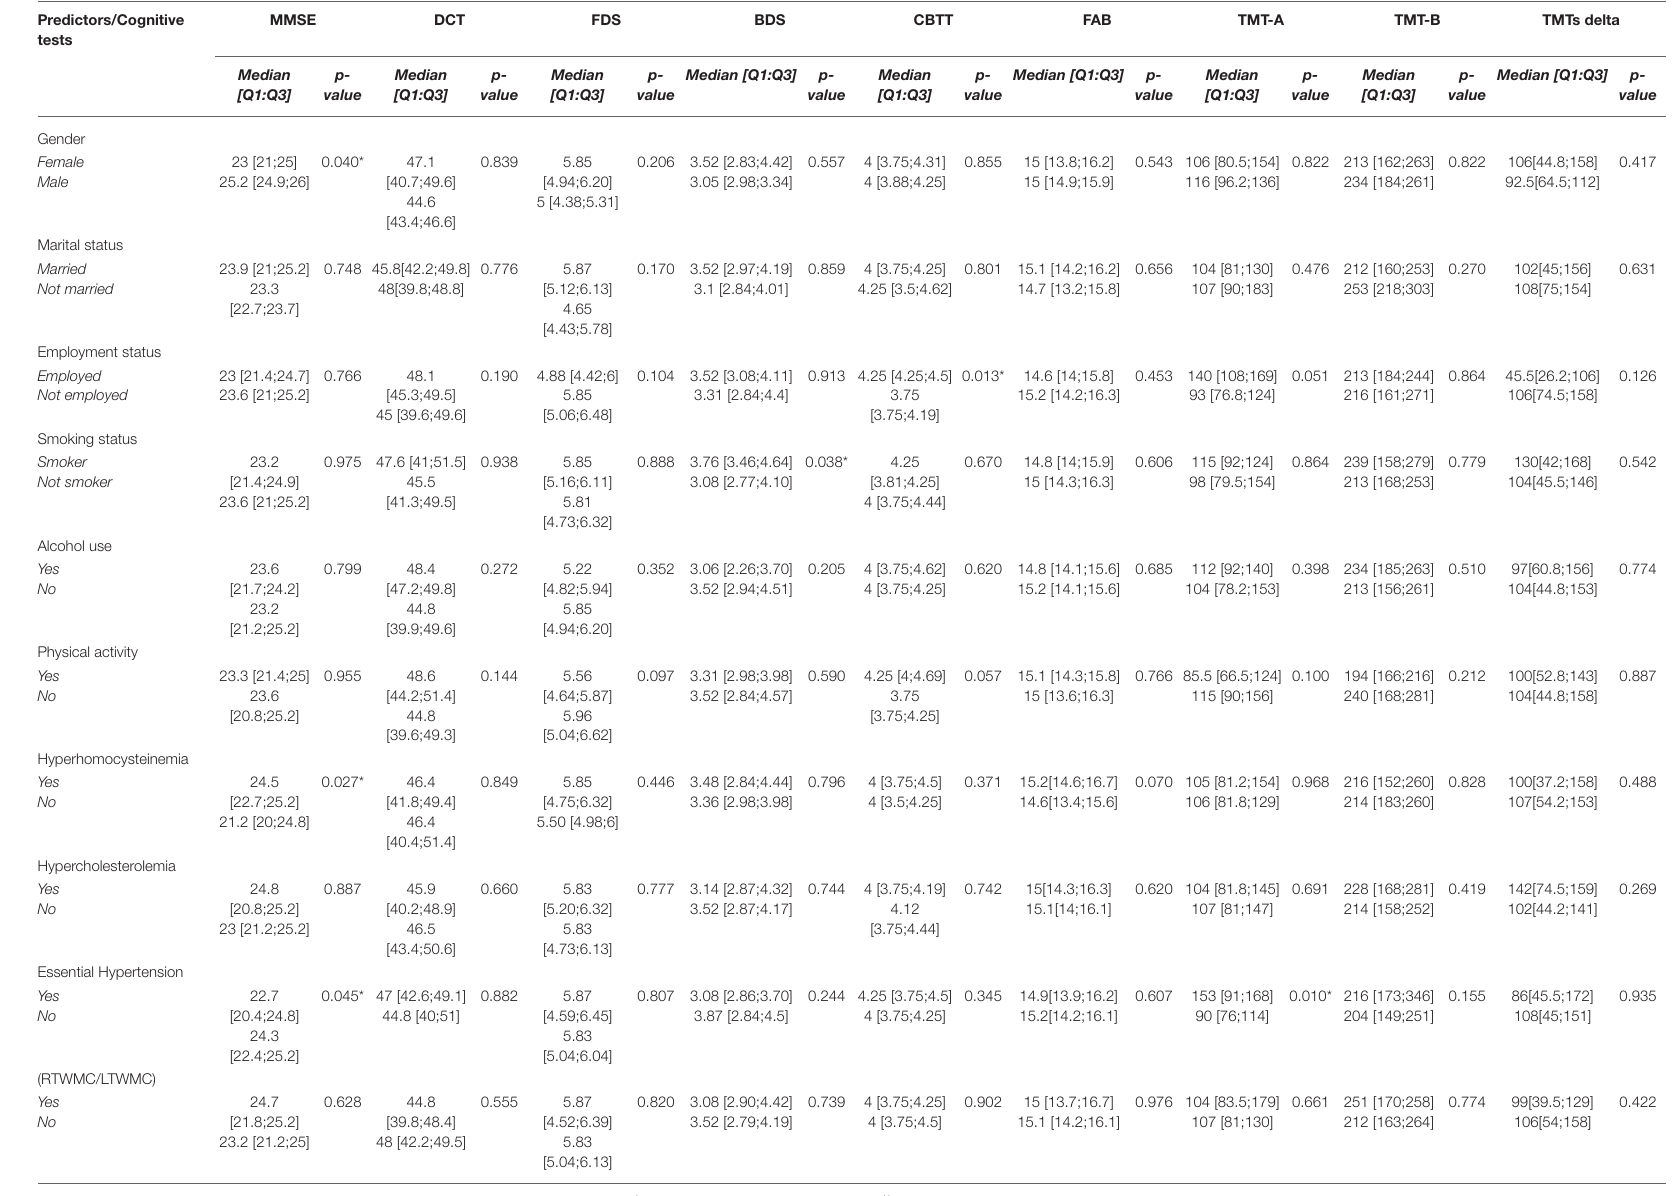
TABLE 9 | Correlation analysis between cognitive tests and qualitative predictors in patients with BMS. Predictors/Cognitive